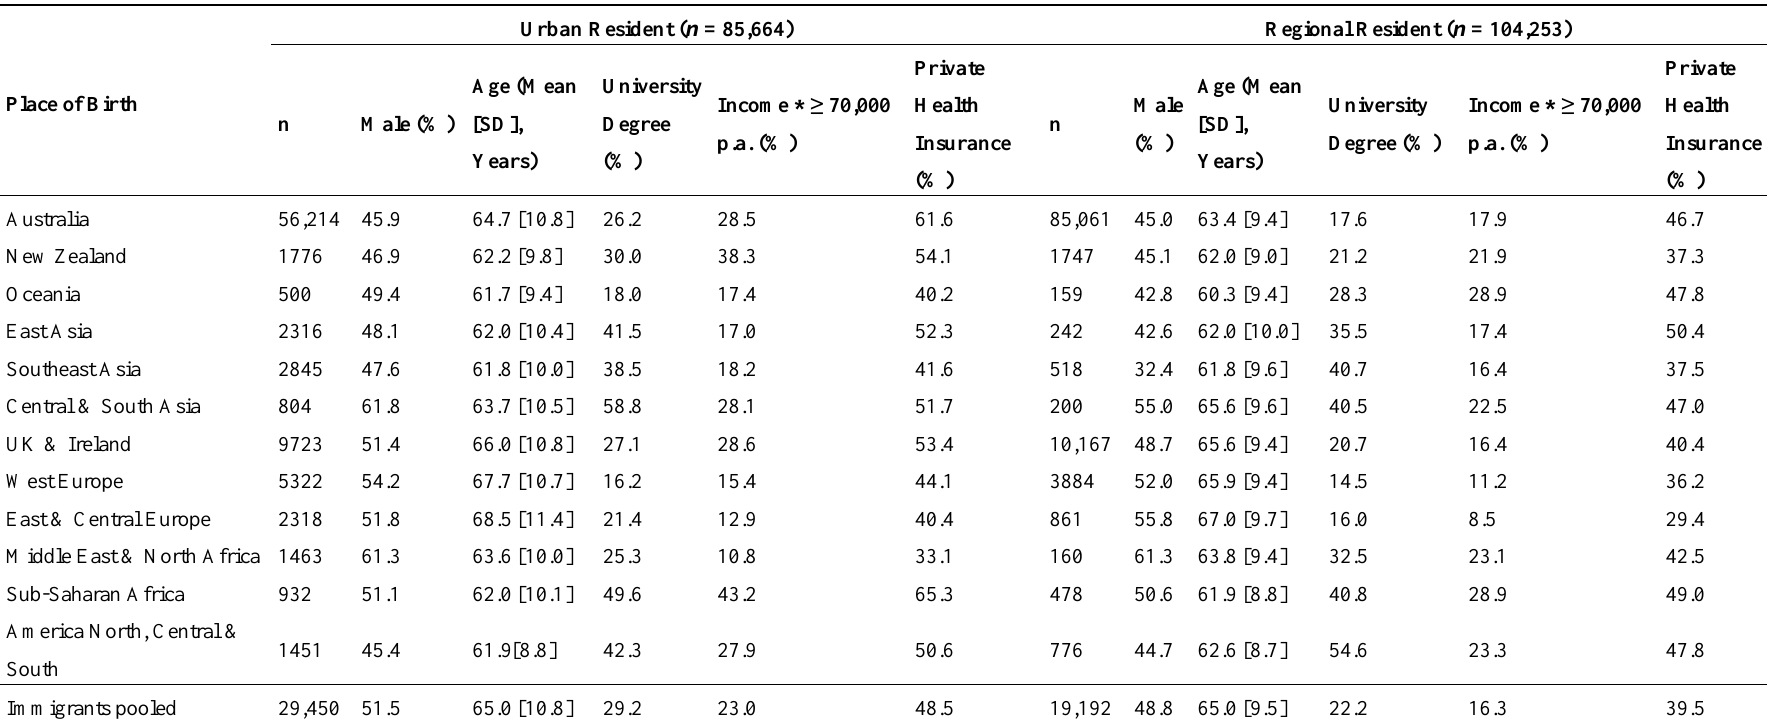
Table 1. Sociodemographic characteristics of the study population according to place of birth (45 and Up Study 2006–2010)